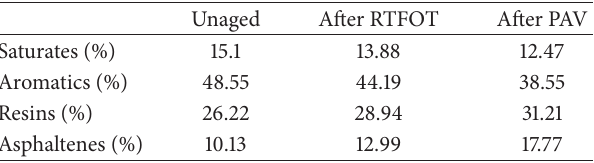
Table 2: The chemical components of the original bitumen before and after ageing.